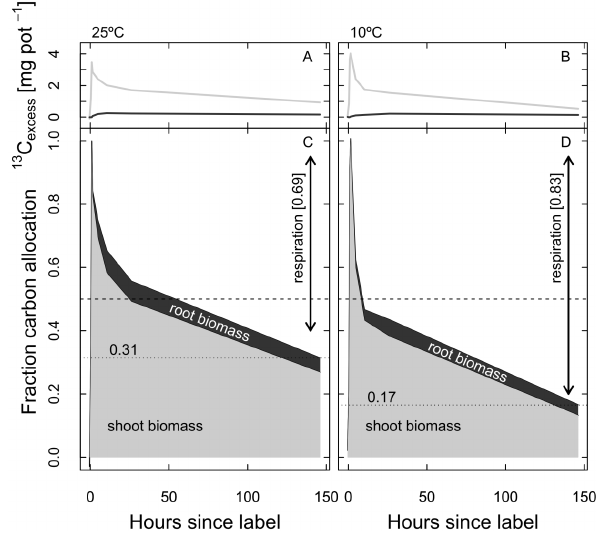
Fig. 3. (A, B) Time course of 13 C excess in shoot (light grey) and root Figure 3: A, B) Time course of 13 C excess in shoot ( light grey ) and root ( dark grey ) and C, D) 3 (dark grey) and (C, D) the derived fraction of carbon allocation rela- the derived fraction of carbon allocation relative to the initial shoot enrichment of shoot bulk 4 tive to the initial shoot enrichment of shoot bulk material ( δ 13 C SB ) ; material (δ 13 C SB ); warm treatment (25 ºC, left panels ); cold treatment (10 ºC; right panels ); 5 warm treatment (25 ◦ C, left panels); cold treatment (10 ◦ C; right final value of biomass allocated to roots and shoots ( dotted line ); 0.5 fraction carbon 6 panels); final value of biomass allocated to roots and shoots (dot- allocation is indicated for reference ( dashed line ). 7 ted line); 0.5 fraction carbon allocation is indicated for reference (dashed